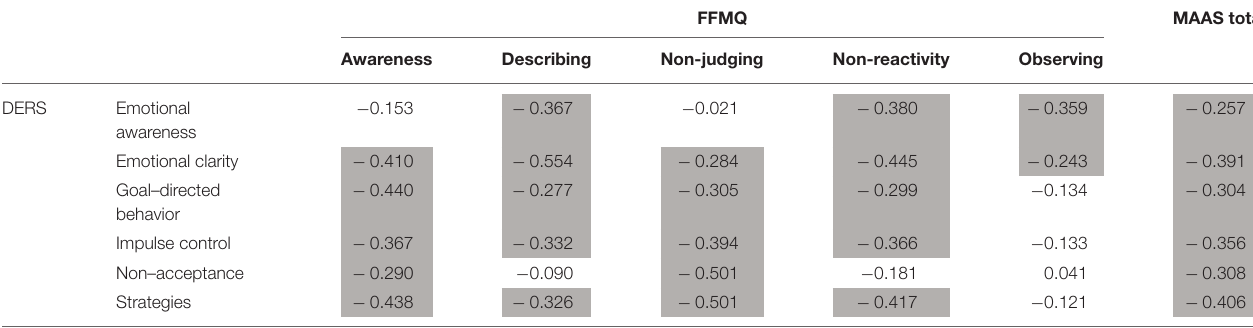
TABLE 2 | Multiple stepwise regression results, regression coefficients, and p -values (in parentheses). FFMQ Awareness Describing Non-judging